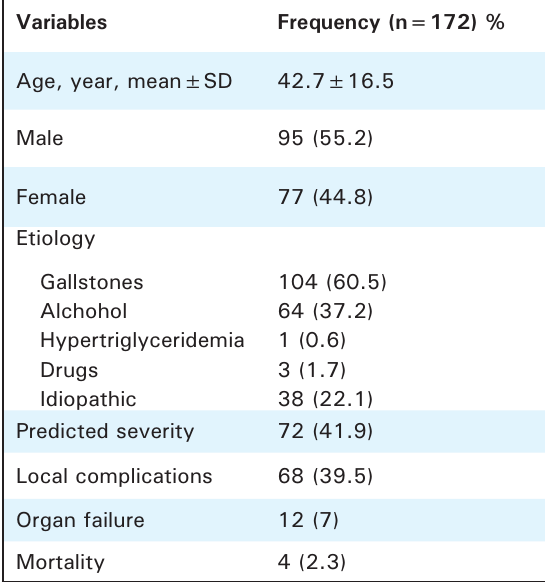
Table 1. Patient demographic characteristics and eti-